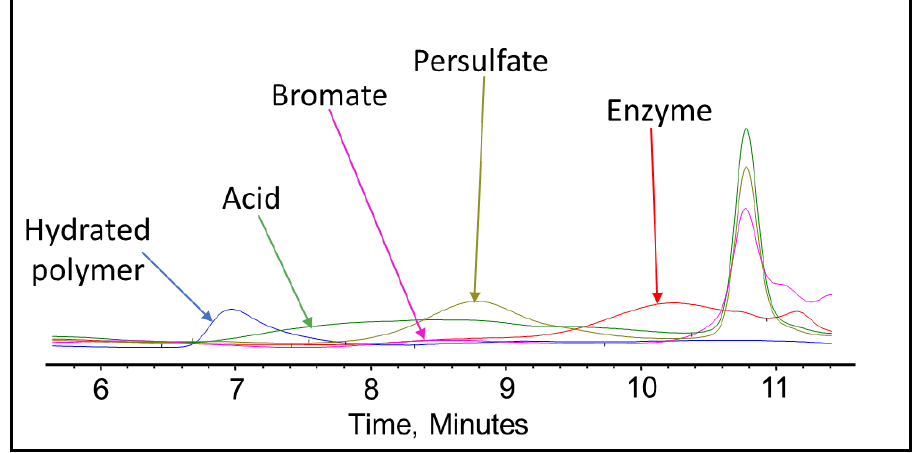
/ 1000 gal crosslinked fracturing fluid exposed to di ff erent gel Figure 10. GPC results of the 45 lb/1000 gal crosslinked fracturing fluid exposed to different gel Figure 10. GPC results of the 45 lb Figure 10. GPC results of the 45 lb/1000 gal crosslinked fracturing fluid exposed to different gel Figure 10. GPC results of the 45 lb/1000 gal crosslinked fracturing fluid exposed to different gel